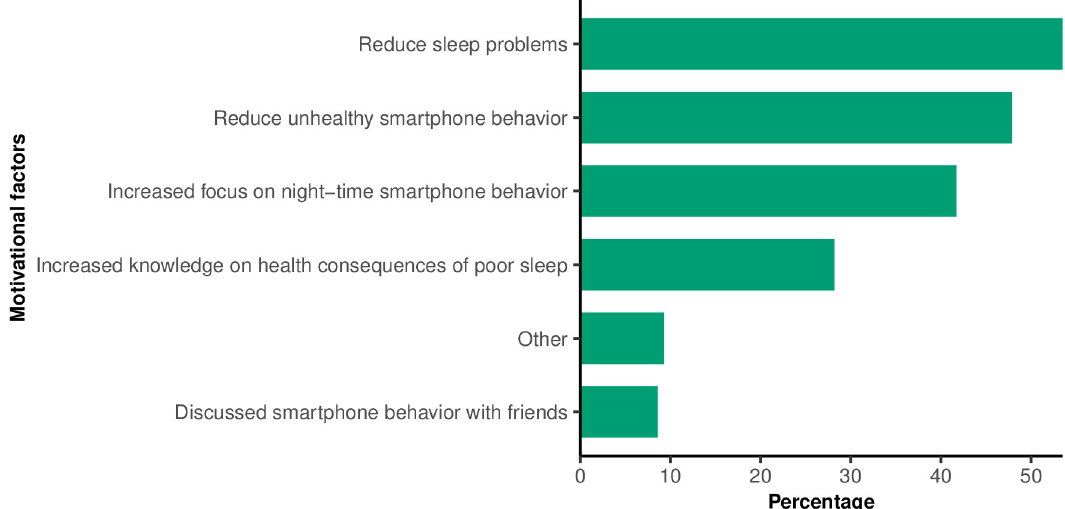
Fig 4. The motivational factors for changes in night-time smartphone behavior among 720 participants who changed behavior in the SmartSleep Experiment .